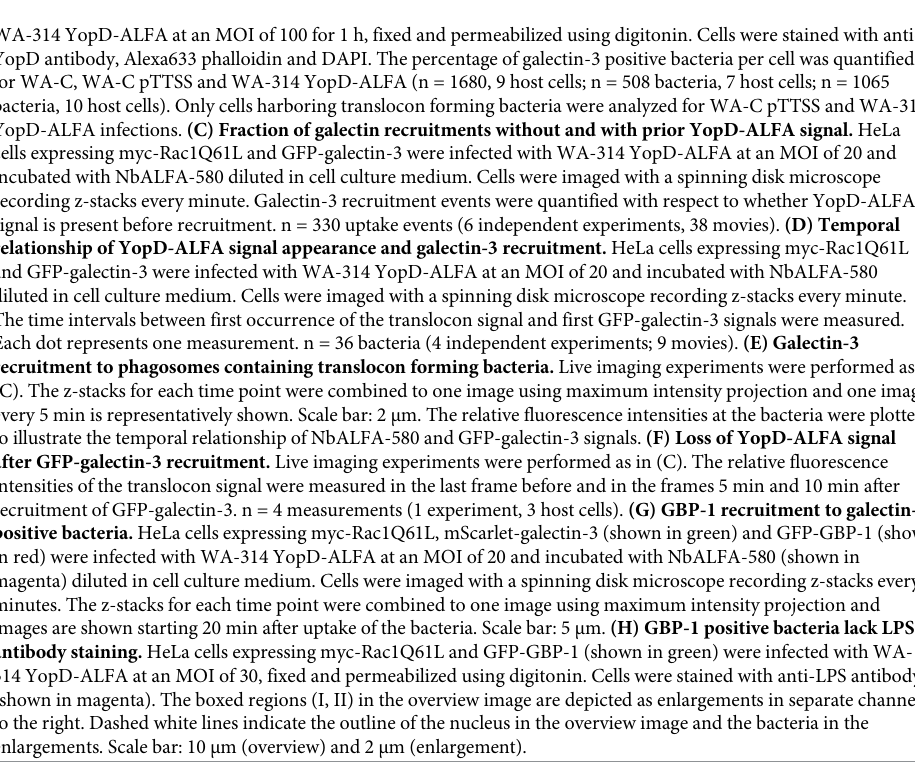
To test the spatiotemporal relation of translocon formation and membrane damage, we infected HeLa cells expressing GFP-galectin-3 with WA-314 YopD-ALFA in the presence of NbALFA-580 and performed live cell imaging. This revealed that GFP-galectin-3 recruitment was preceded by detectable YopD-ALFA signals in 92.6% +/- 5.6% (mean +/- S.D.) of all GFP- galectin-3 recruitment events (Fig 4C). The mean time interval between translocon formation and GFP-galectin-3 recruitment was determined to be 13.9 +/-6.3 min (mean +/- S.D., Fig 4D). We also noticed that GFP-galectin-3 was recruited relatively abruptly to the entire phago- somal membrane and that its recruitment was accompanied by a decrease in the YopD-ALFA translocon signal (n = 4; Fig 4E and 4F and S4 Movie). After we excluded that photobleaching